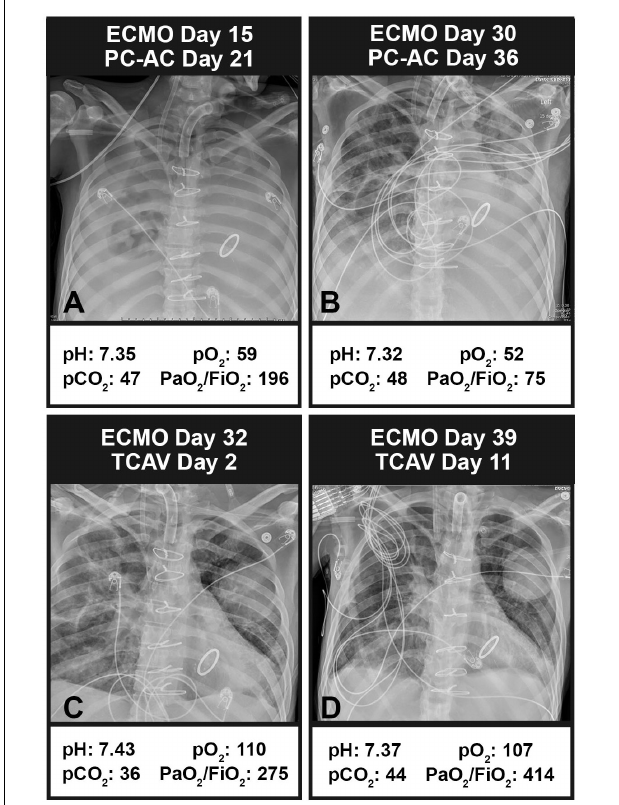
FIGURE 13 | Chest X-rays (CXRs) and blood gases in a patient with respiratory failure on extracorporeal membrane oxygenation (ECMO). (A) CXR and blood gases (arterial pH, PCO 2 , and PO 2 with the calculated PaO 2 /FiO 2 ratio) at 15 days on ECMO and protective ARDSnet pressure-control assist-control ventilation (PC-AC). Bilateral infiltrates can be seen throughout the lung with a PaO 2 /FiO 2 ratio of 196. (B) After 30 days on ECMO and PC-AC, the patient showed some clearing in the upper right quadrant but a worsening PaO 2 /FiO 2 ratio of 75. (C) Two days after conversion to the TCAV method, the patient showed marked improvement in CXR and PaO 2 /FiO 2 ratio (275). (D) After 11 days on the TCAV method, the patient showed a cleared CXR and normalized PaO 2 /FiO 2 ratio (414). The patient came off of ECMO and was extubated. Written informed consent obtained for the use of these